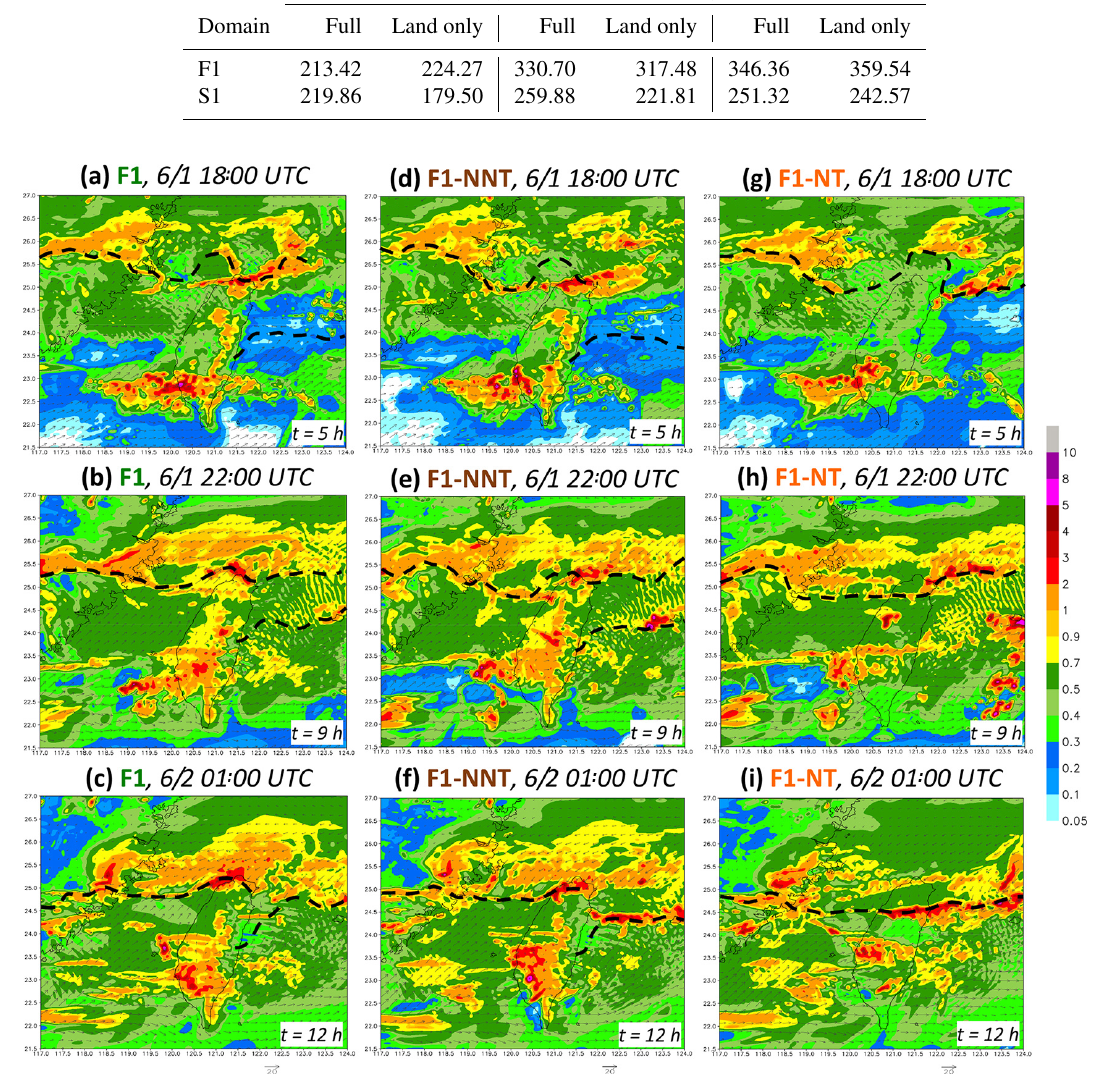
Figure 7. Model surface winds at 10m height (ms − 1 , reference vector at bottom), frontal position (thick dashed line), and column-maximum mixing ratio of precipitating hydrometeors (rain + snow + graupel, gkg − 1 , color) near Taiwan in the F1 experiment at (a) 18:00, (b) 22:00 on 1 June and (c) 01:00UTC on 2 June 2017. As in (a) – (c) , except in experiment (d) – (f) F1-NNT and (g) – (i) F1-NT, respectively. The model time (h) is also labeled in each